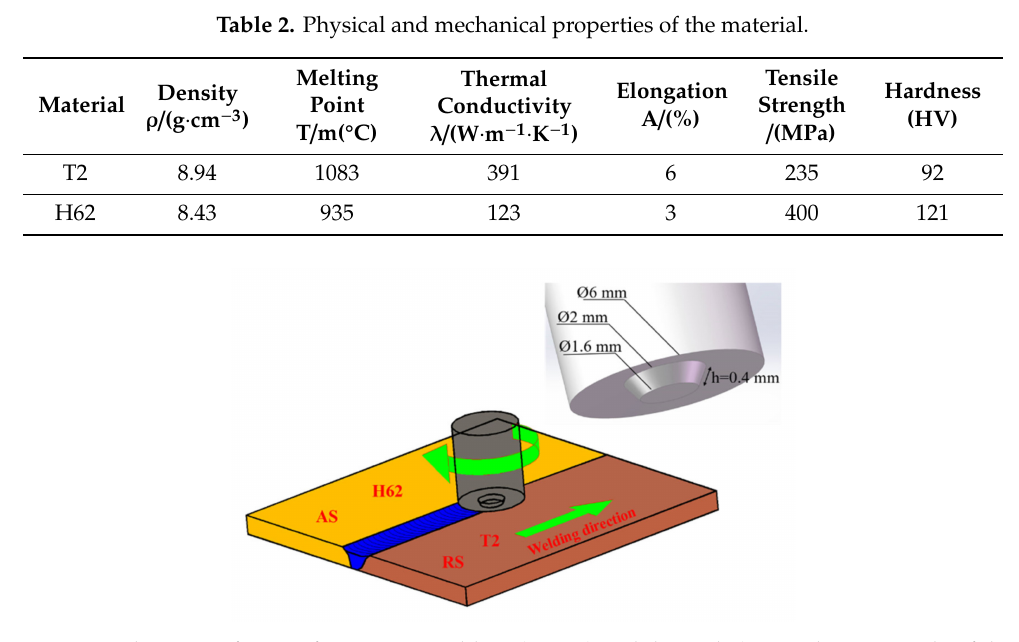
Figure 1. Schematic of micro-friction stir welding ( µ FSW) and the tool. (AS—advancing side of the weld-brass-H62; RS—retreating side of the